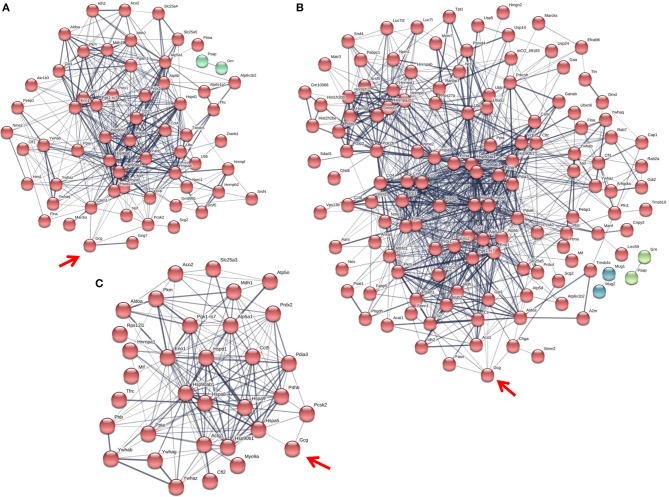
The glucagon interactome is altered in response to paracrine effectors in 5.5 mM glucose. α-TC1-6 cells were transfected with Fc-glucagon or Fc alone, and treated with GABA (25 μM), insulin (100 pM) or GABA (25 μM) plus insulin (100 pM) for 24 h in DMEM containing 5.5 mM glucose. Fc-glucagon was purified from isolated secretory granules and associated proteins were identified by LC-MS/MS. (A) Proteomic map of metabolic-regulatory-secretory proteins that are associated with glucagon after treatment of α-TC1-6 cells with GABA shows direct interactions with 6 proteins: GRP78, Heat shock protein 90- alpha (Hsp90aa1), Protein convertase subtilisin/kexin type2 (PCSK2), Heat shock 70 kDa protein 1B (Hspa1b), Calmodulin 1 (Calm1), Guanine nucleotide-binding protein G(I)/G(S)/G(O) subunit gamma-7 (Gng7). (B) After treatment with insulin, glucagon is predicted to directly interact with 7 proteins: GRP78, Heat shock protein 90-alpha, Annexin A5 (Anxa5), Stathmin1 (Stmn1), PCSK2, Fatty acid synthase (Fasn), and Chromogranin A (Chga). (C) After treatment with GABA + Insulin, glucagon is predicted to directly interact with GRP78 and PCSK2. Line thickness indicates the strength of data support.